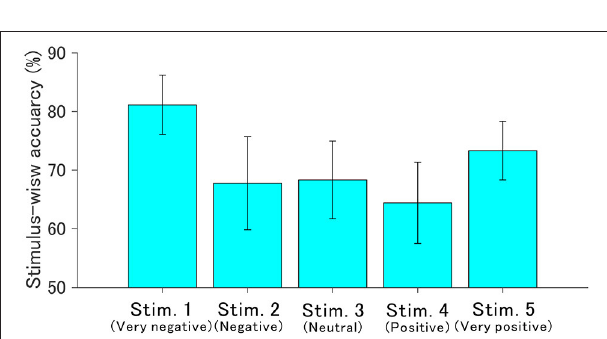
FIGURE 6 | Offline stimulus-wise classification accuracy and standard error for each auditory stimulus. These were calculated based on ERP data in the ROI (400–700 ms in C3, Cz, and C4). The number of stimulus sequences (repetitions) was fixed to 10